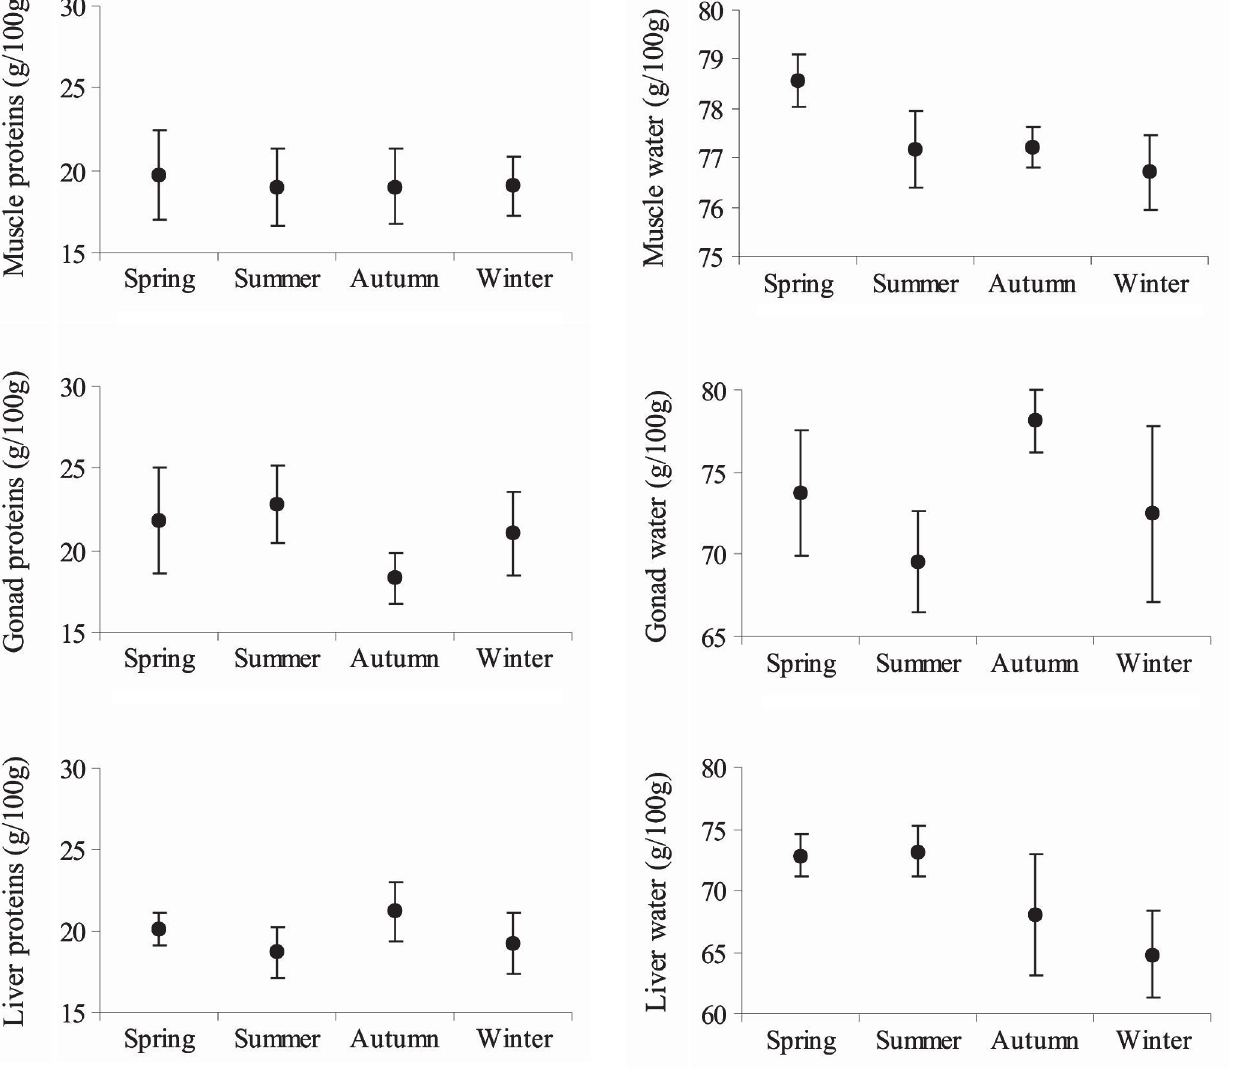
Fig. 3. Seasonal variation of protein content in muscle, gonad and liver of Percophis brasiliensis .